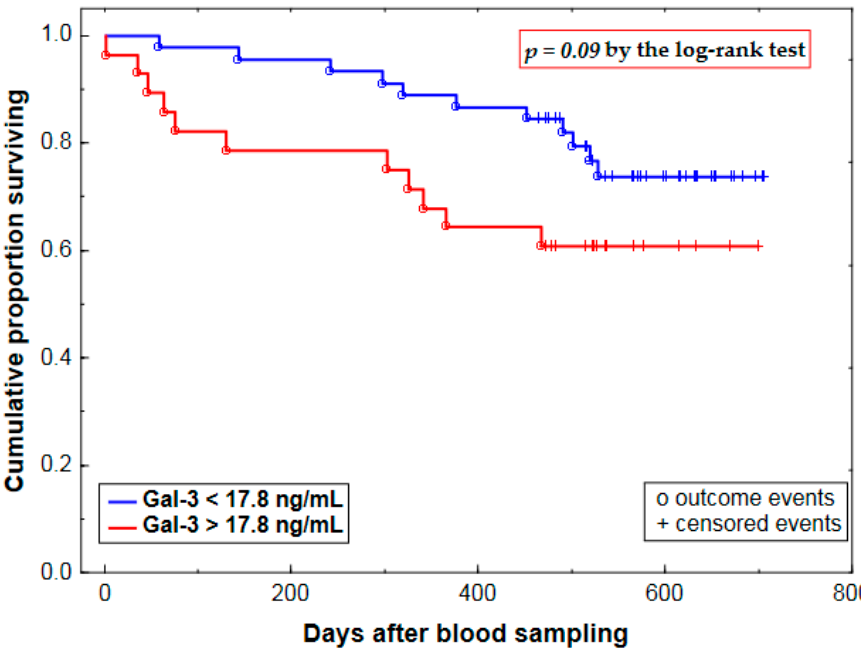
Figure 2. Kaplan–Meier survival curves by baseline plasma galectin-3 (Gal-3) for all patients with aortic stenosis irrespective of type of treatment employed.